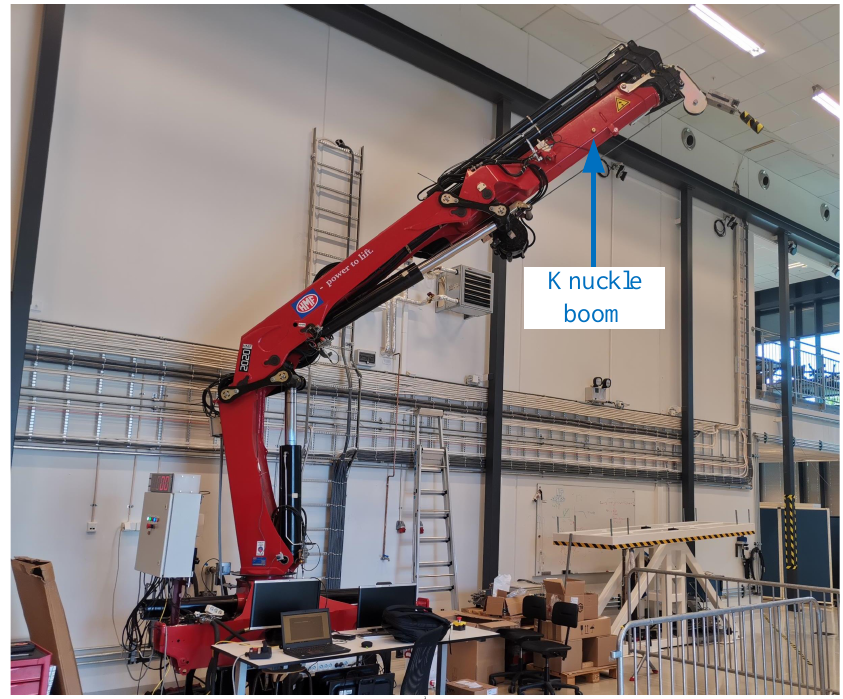
Figure 22. HMF 2020K4 loader crane in the